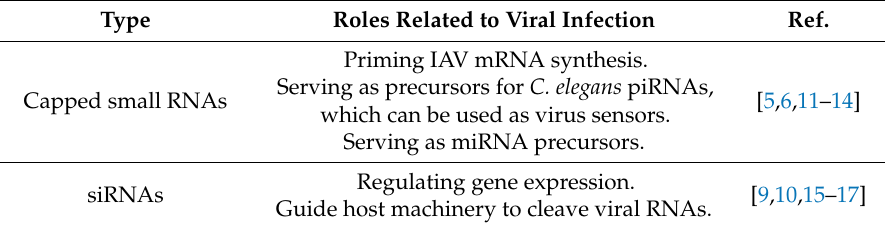
Table 1. The roles of small RNAs in virus–host interaction. Type Roles Related to Viral Infection Ref. Priming IAV mRNA synthesis. Serving as precursors for C. elegans piRNAs, Capped small RNAs which can be used as virus sensors. Serving as miRNA precursors. Regulating gene expression. siRNAs Guide host machinery to cleave viral